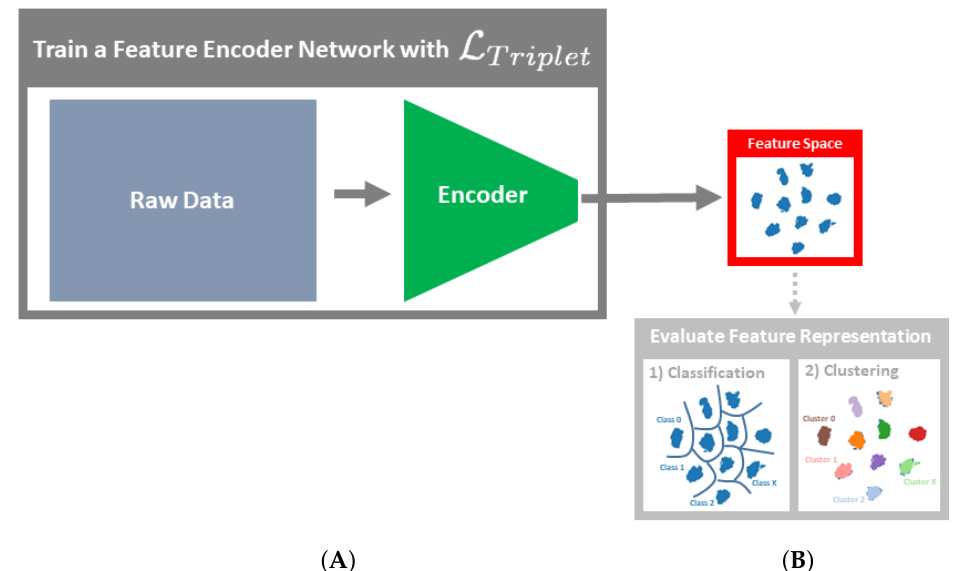
Figure 1. Methodology schemes of ( A ) training a feature representation with the triplet loss and ( B ) evaluating the learned feature representation (classification and clustering) with respect to the objectives of achieving invariance to novel operating conditions and sensitivity to novel